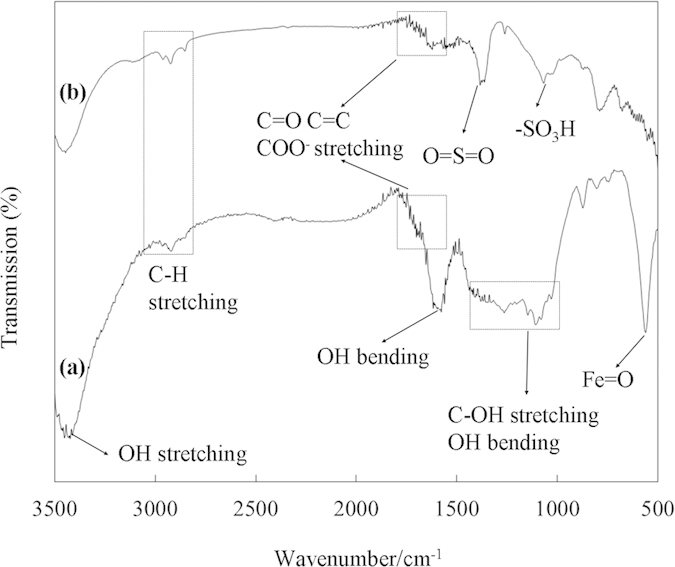
FT-IR spectra of magnetic catalyst: (a) before sulfonation (C/Fe3O4) and (b) after sulfonation (C-SO3H/Fe3O4).